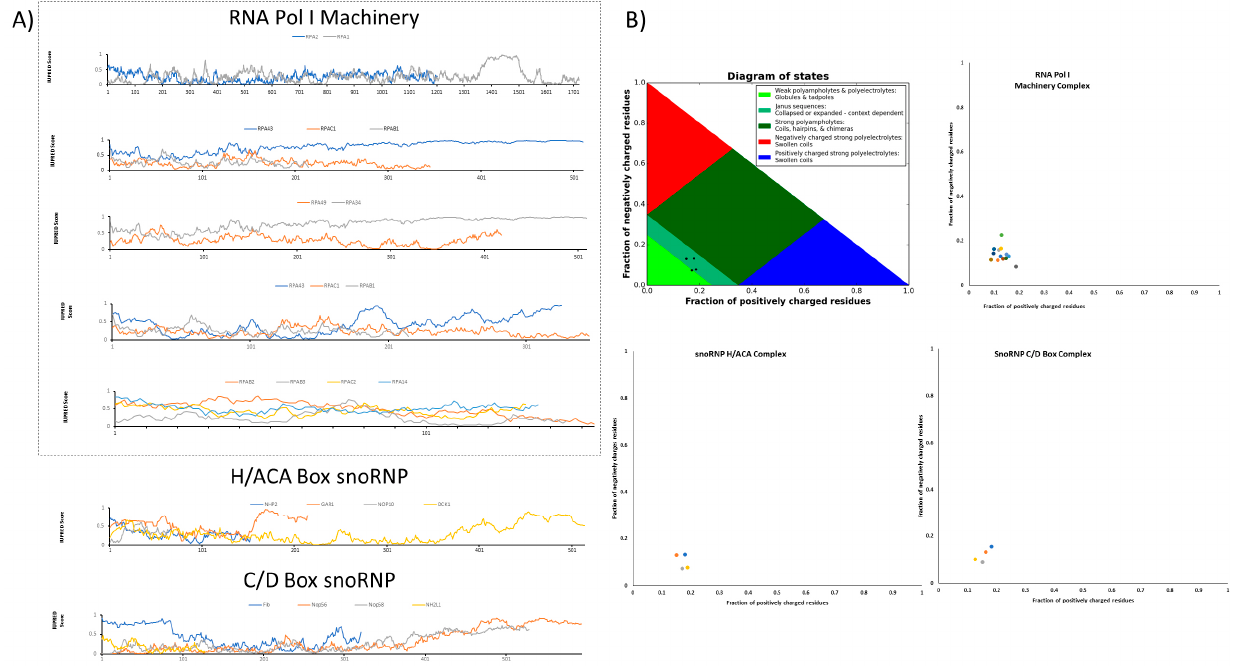
Figure 3. Intrinsically disordered regions in some key protein components during rRNA metabolism drive the LLPS behavior of the nucleolus. ( A ) The intrinsically disordered tendency of the RNA Pol I machinery and the well-characterized snoRNP complexes driving pseudo-uridylation and methylation, snoRNP H/ACA, and snoRNP C/D Box, respectively. As calculated by IUPred algorithm (www.iupred2a.elte.hu, accessed on 11 March 2021), a tendency to disorder is predicted when values per residue exceed the 0.5 IUPred scores. Intrinsically disordered regions vary between complexes and between N- and C-terminal domains, for example, the major RPA1 factor of RNA Pol I exhibit a tendency to disorder in its C-terminal domain and the GAR1 protein founded in the H/ACA complexes. In contrast, fibrillarin from the C/D Box complex displays a well-documented disordered region in its N-terminal domain. ( B ) Diagram phases computed with the CIDER (Classification of Intrinsically Disordered Ensemble Regions; www.pappulab.wustl.edu/CIDER, accessed on 11 March 2021) algorithm showing the expected conformation that IDP could adopt ranging from globules and tadpoles, collapsed or expanded, coils and hairpins, and swollen coils. Although the disordering tendency shows a set of proteins containing IDR, each corresponding diagram phase indicates a small tendency to phase separate. As shown in the phase diagrams, the majority of the proteins involved in the complexes fall in the phase two plot region, as a collapsed and extended region. This corresponds to the idea that LPPS is coupled to other energy-consuming processes that in the last step promotes a multicomponent phase-separated nucleolus. Protein names were omitted in the plots to prevent overlapping.